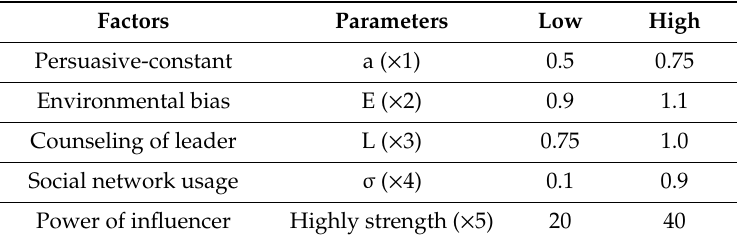
Table 1. Factors and levels for experimental design.